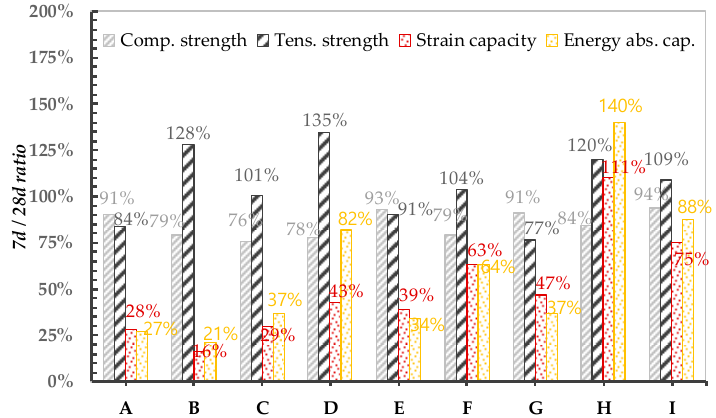
Figure 15. Ratios of 7 d–28 d cured for test parameters.